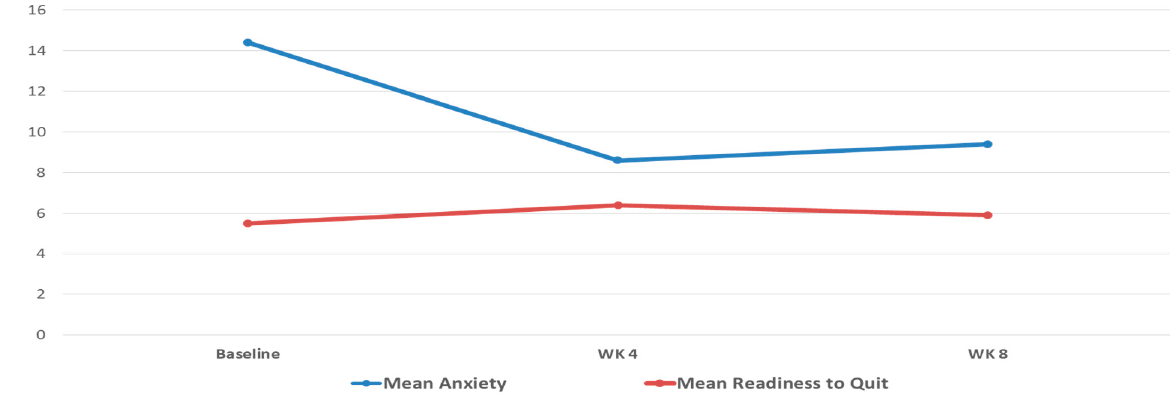
Figure 1. Mean Anxiety and Readiness to Quit at Baseline, Week 4, and Week 8.